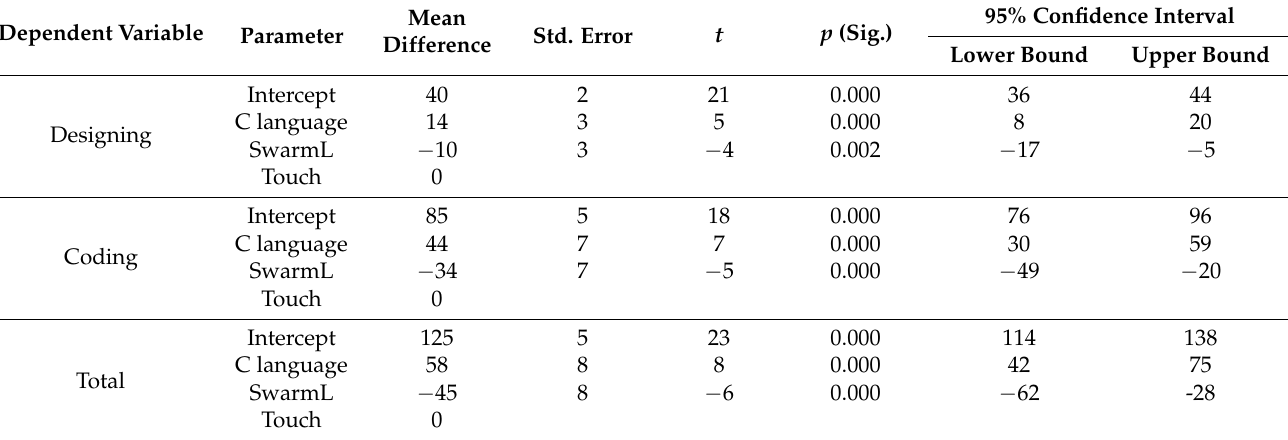
Table 4. Results of multiple comparisons.